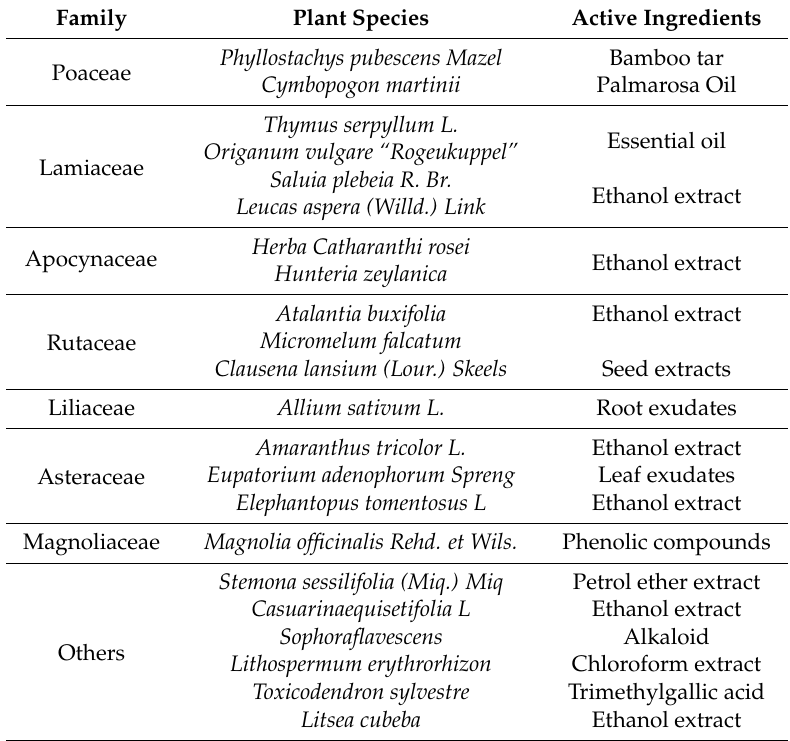
Table 1. Several phytochemicals with inhibitory activity to R.